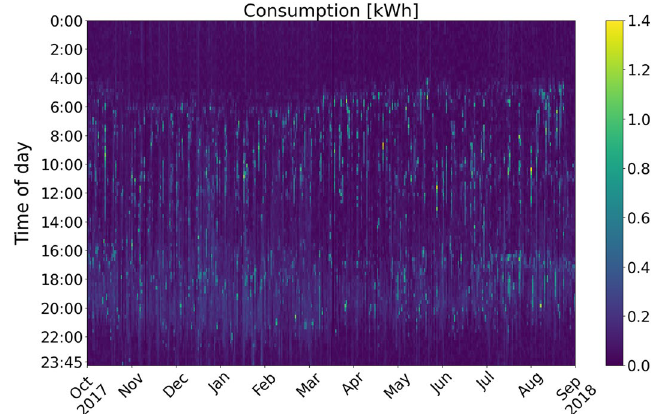
Fig. 8 One year of consumption data of the household with the lowest matching accuracy from the 100-household test